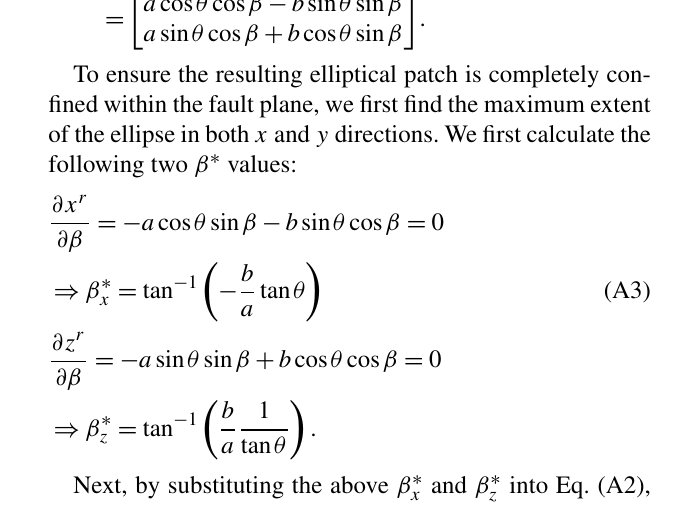
Algorithm 1 Unrestricted mapping – PC random